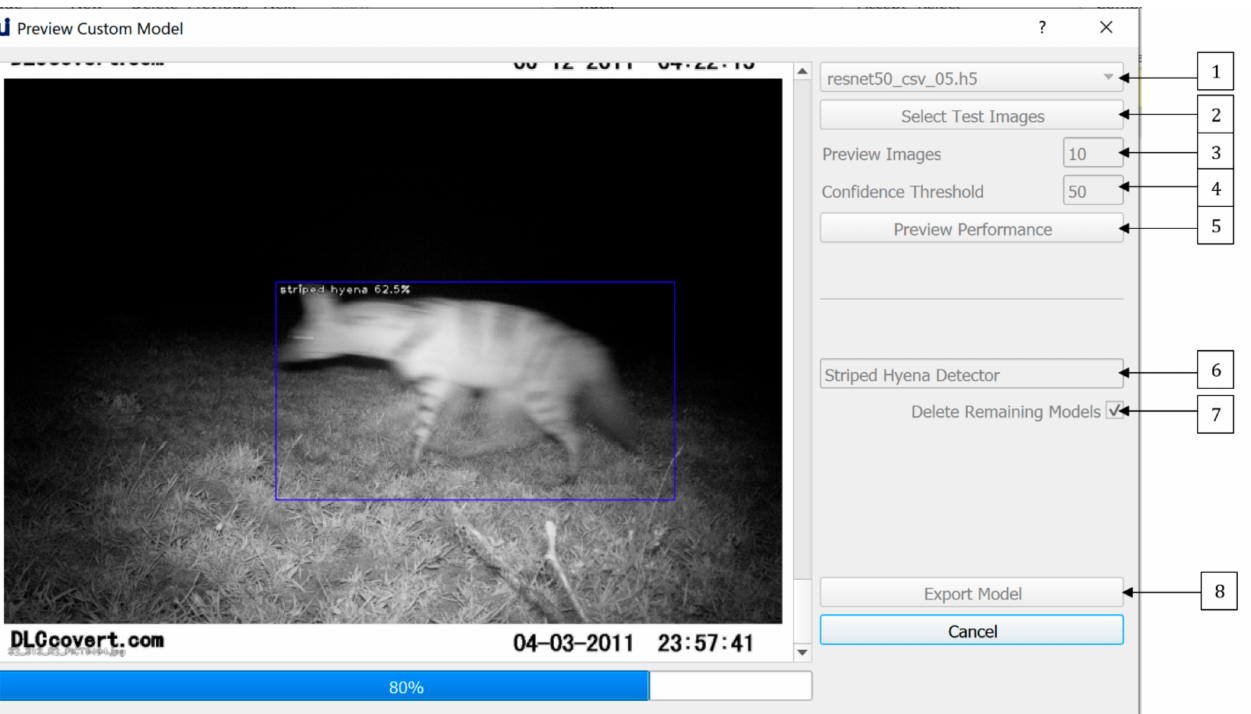
Figure 8. The Preview Custom Model dialogue allows the user to preview the performance of custom trained models on a small subset of randomly sampled test images. It also allows users to export chosen models for future